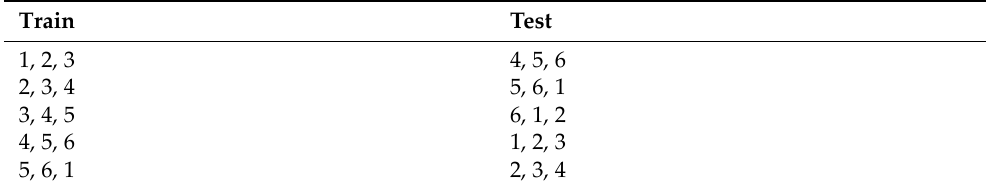
Table 18. A training set and test